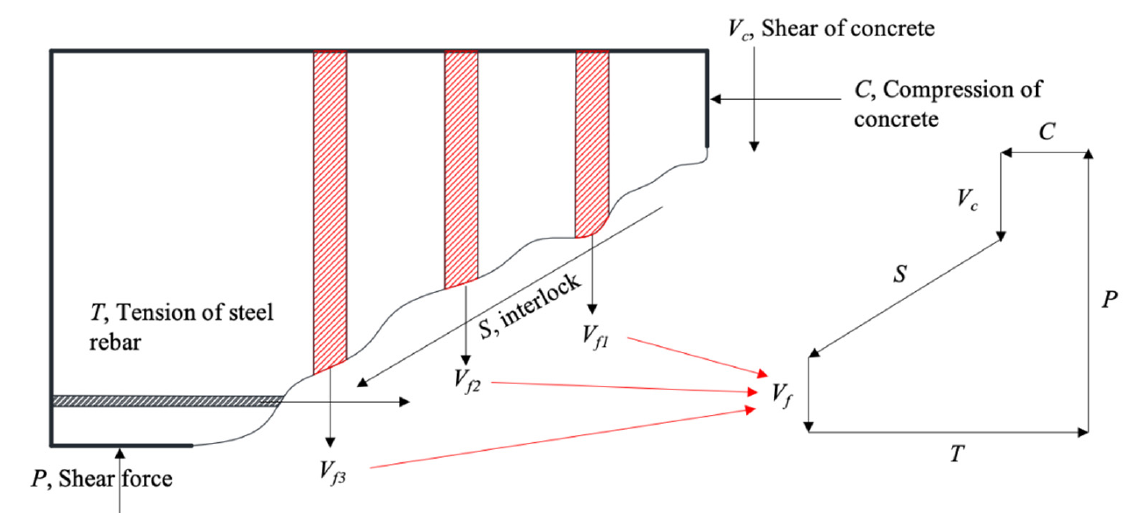
Figure 12. Force equilibrium. Figure 12. Force Table 4. Shear capacity contribution.